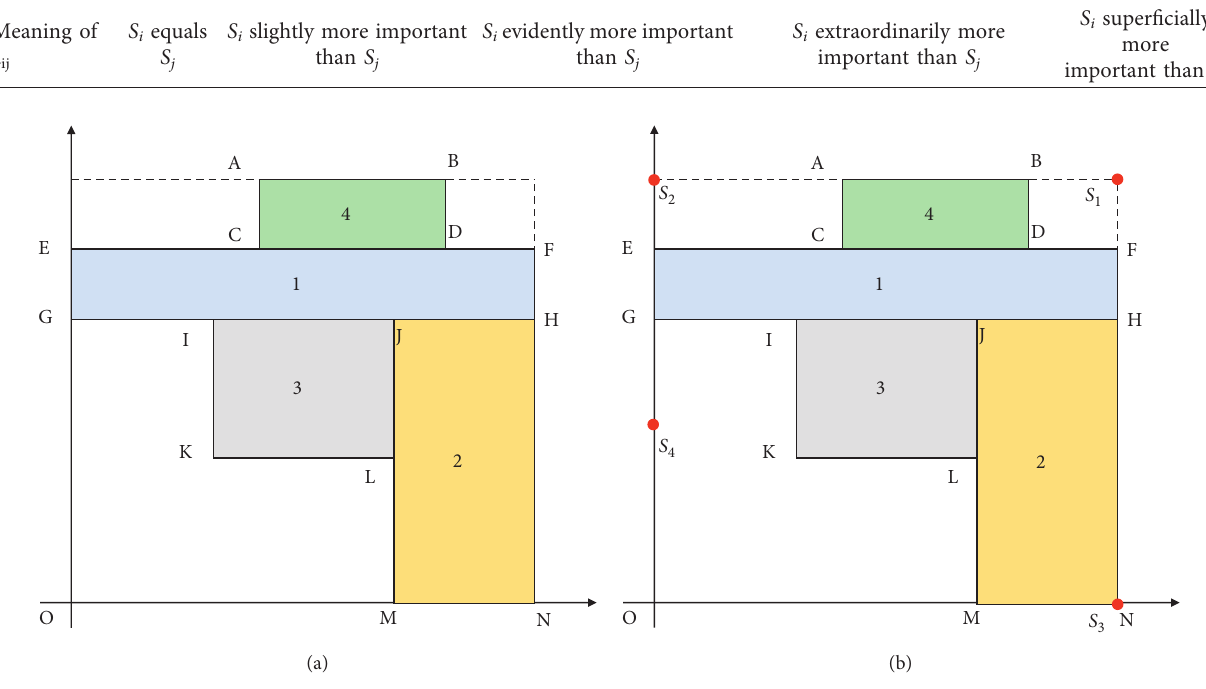
Figure 5: Base station layout considering different positioning accuracy requirements. Table 3: Simulation results of plane accuracy factors for each localization